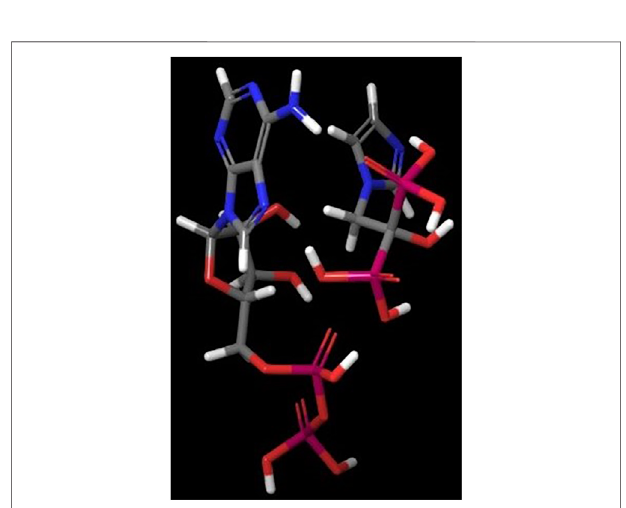
FIGURE 6 | Zoledronic acid is a nitrogen-containing molecule whose structure shows similarities also with nucleotides. Blue colour = Nitrogen atom, Grey = Carbon atom, White =Hydrogen atom, Red =Oxygen, Purple= Phosphate groups. Left-hand ADP and right-hand zoledronic acid molecules,